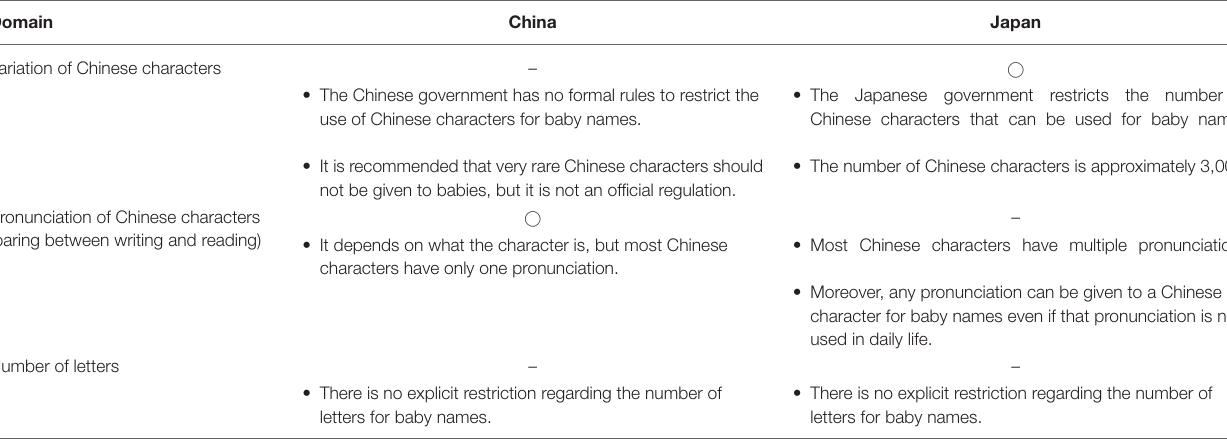
TABLE 1 | Summary of restrictions in giving names to babies in China and Japan.